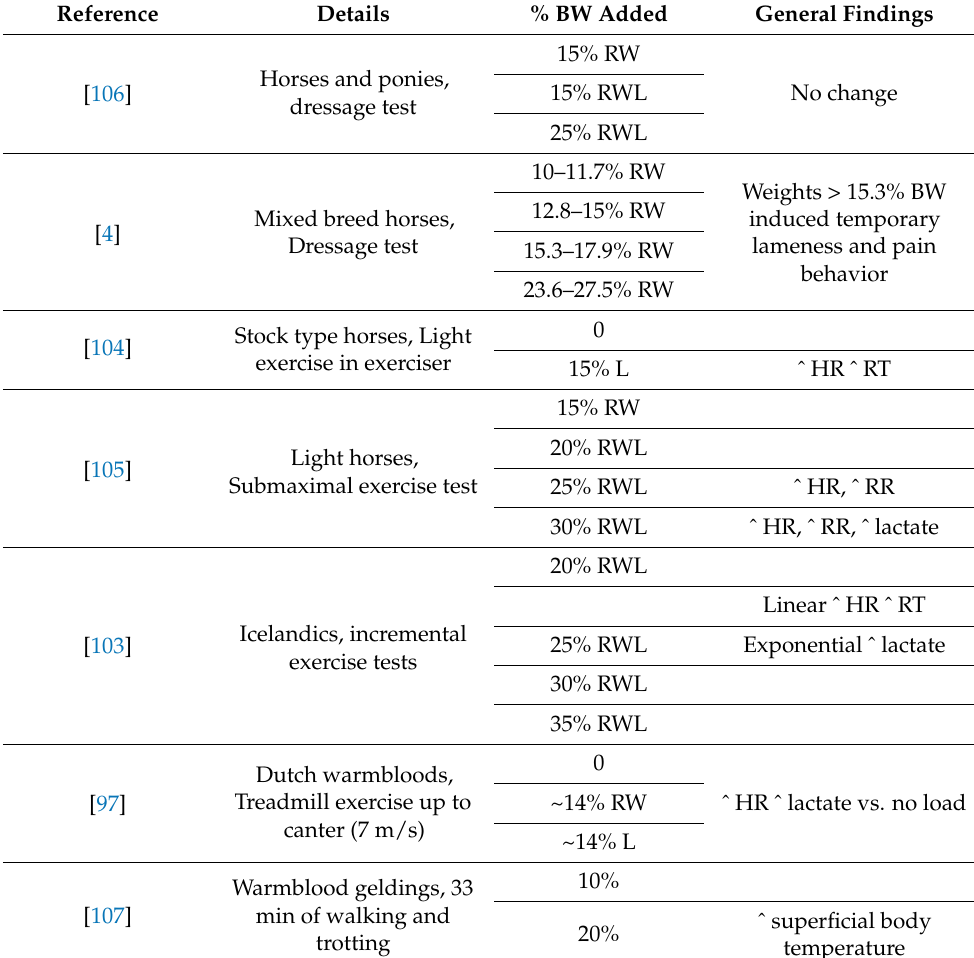
Table 1. Effect of added weight on exercise related